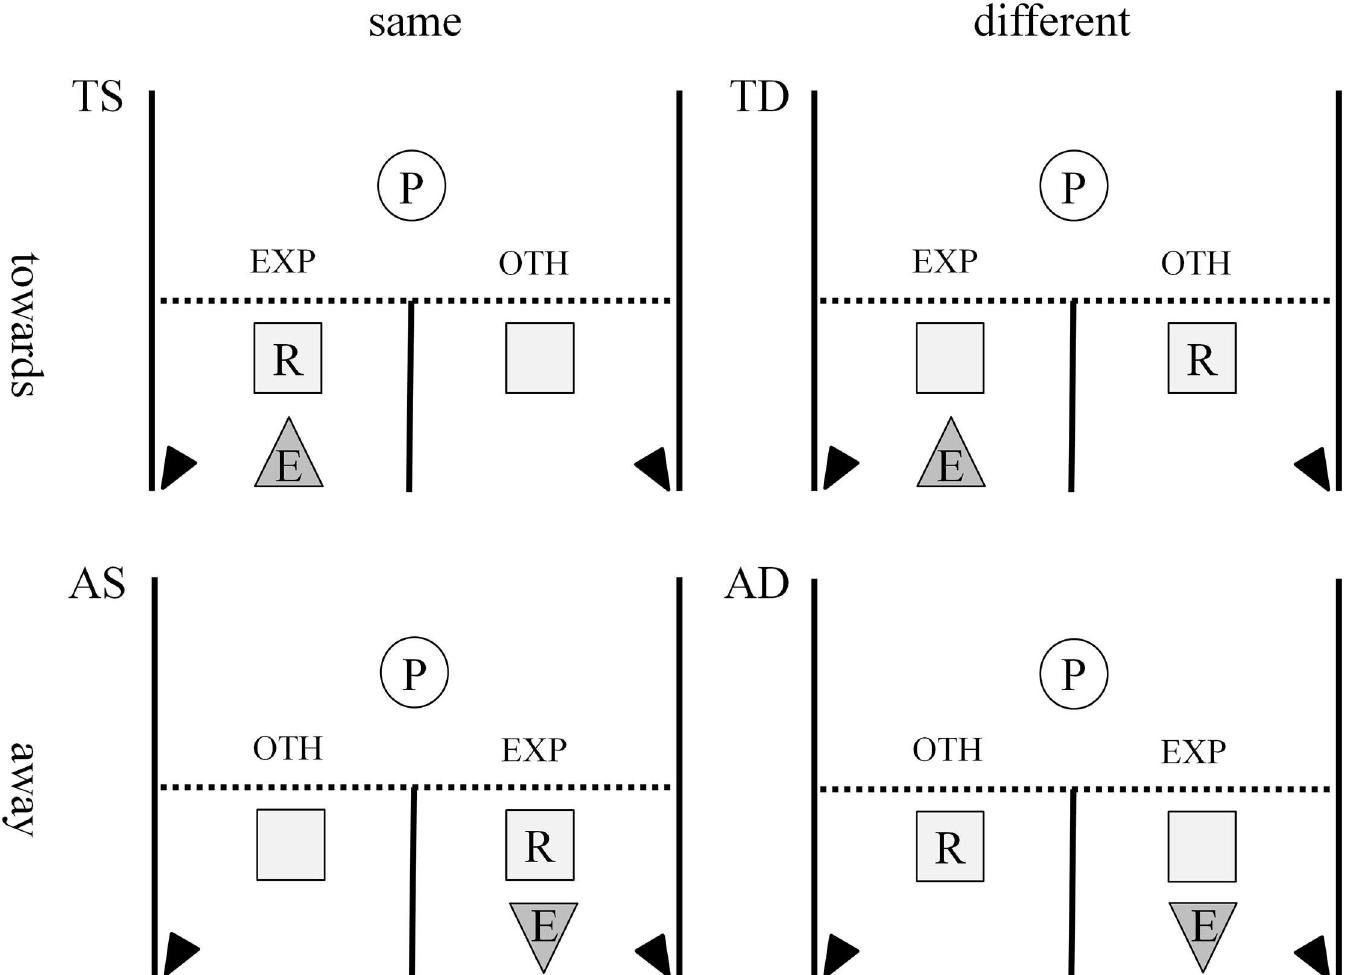
Fig 1. Experimental set-up in all conditions. (R = reward; E = experimenter; P = participant; dotted line = transparent barrier; central solid line = opaque visual barrier; squares = containers; black trianglesat the bottom left and right corners: cameras). In a two by two study designwe variedwhether the experimenter was orientedtowards the participant(upper row; indicatedby a trianglefacing upwards)or away from the participant (lower row; indicatedby a triangle facing downwards) and whetherthe experimenter and the rewardwere locatedon the same side (left column)or on different sides (right column) resultingin the four experimental conditions towards-same (TS), towards-different (TD), away-same (AS) and away-different (AD); EXP: experimenter side, OTH: other side.